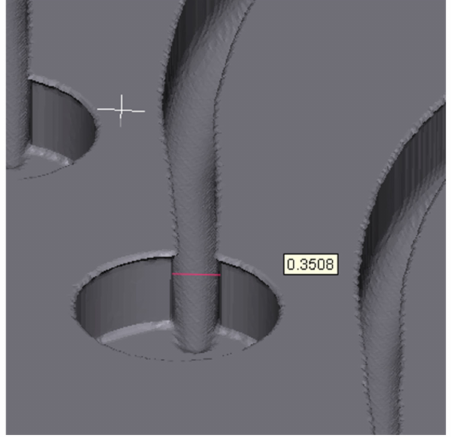
Figure 3. Close-up from of the artificial root canal (size +0.10 mm) with the diameter of the apical constriction in